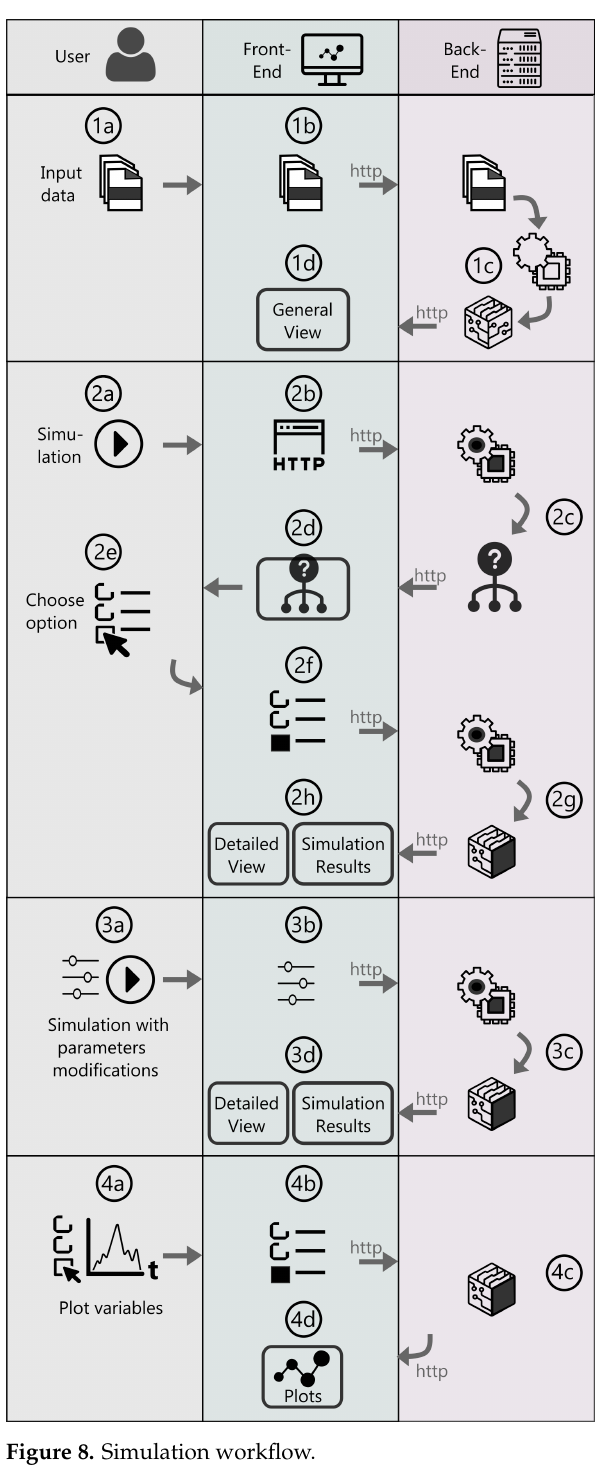
Figure 8. Simulation